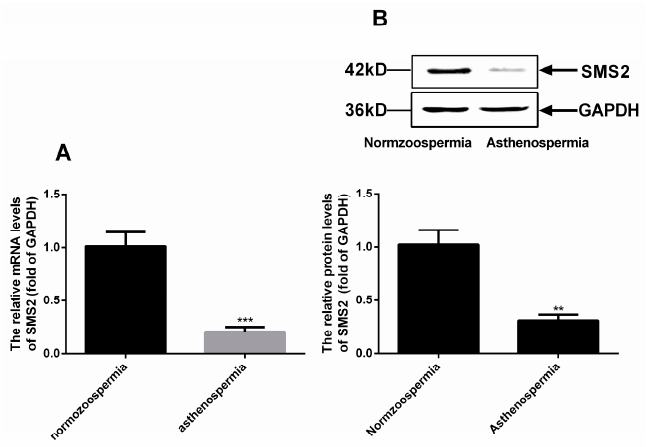
Figure 2. The expression of SMS2 in asthenospermia and normozoospermia. ( A ) mRNA levels of SMS2, *** p < 0.001; ( B ) protein levels of SMS2. Values shown are the mean ± SD ( n = 20), ** p < 0.005 vs. normozoospermia.